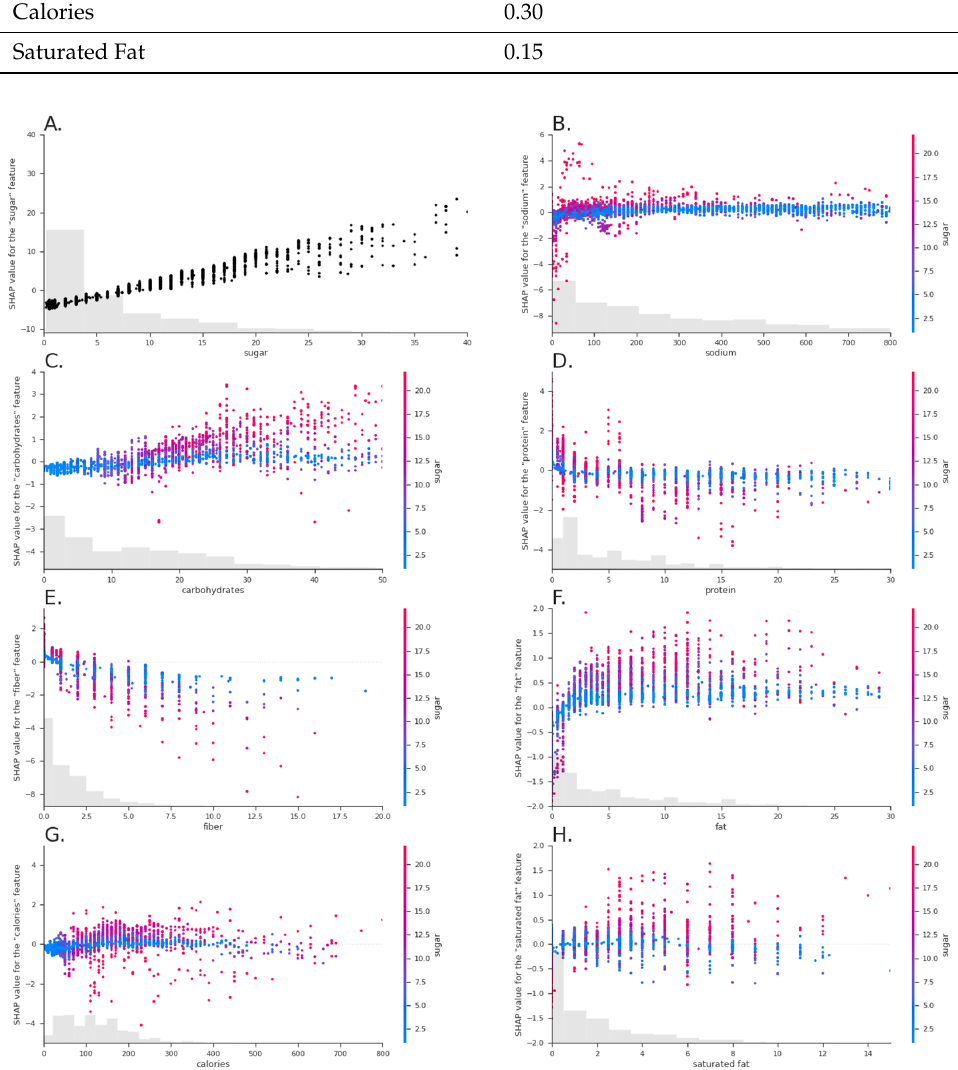
Figure 3. SHAP dependence plots. The value of the feature is displayed on the horizontal axis, while the vertical axis shows how much the value of a feature changed the final model prediction, with each dot representing a specific food. The bars at the bottom of each chart represent histograms showing the distribution of the feature, e.g., for plot A the histogram indicates that most foods in the dataset contain 0 to 5 g of sugar. Blue colors in plots ( B – H ) indicate low sugar values, while red colors indicate high sugar values. ( A ) The final model prediction for added sugar depends roughly linearly on sugar. ( C ) For foods with a high value of sugar, the presence of a high amount of carbohydrates indicates higher added sugar values than for foods that are low in sugar. ( D ) Only for high values of sugar does the prediction of added sugar depend on protein. For high values of sugar, lower values of protein indicate higher values of added sugar. ( E ) Low values of fiber indicate higher values of added sugar, especially if the food contains high amounts of sugar.